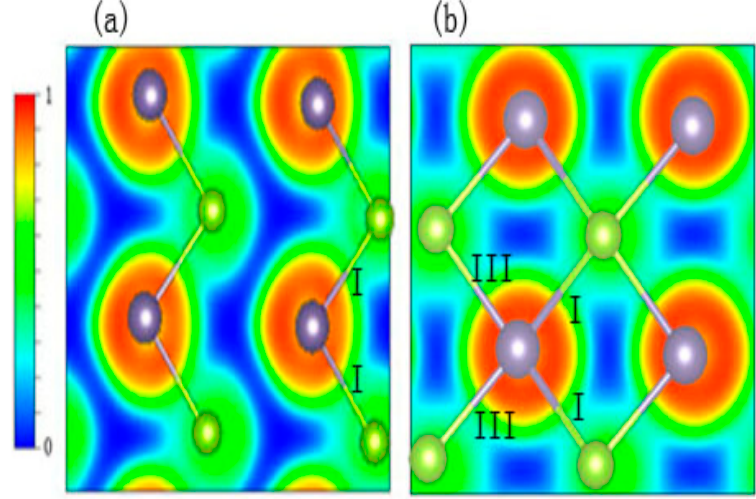
Figure 6. The ELF values of GeSe projected to a layered plane under ( a ) 0 GPa and ( b ) 37 GPa.